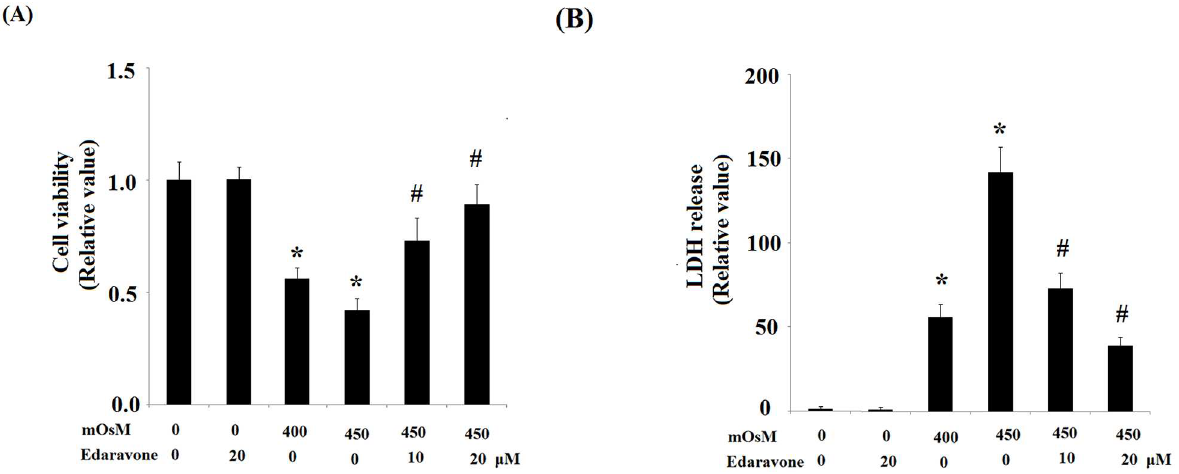
Fig 4. Edaravone prevents cell death induced by exposure to hyperosmotic media (400–450mOsM). (A) Cell viabilitywas measuredby MTT assay; (B) Cell death was measuredby LDH release assay. All experiments were repeatedat least three times (ANOVA: * , P < 0.001vs. untreated control; #, P < 0.001vs. 450 mOsM treated group).